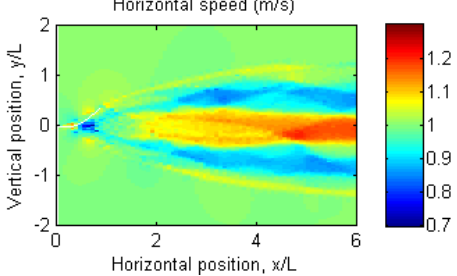
Fig. 14. Mean axial velocity in the